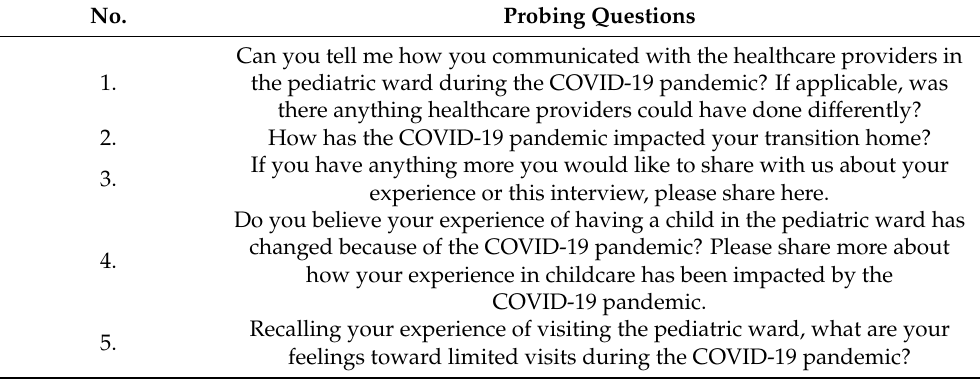
Table 1. Probing open-ended